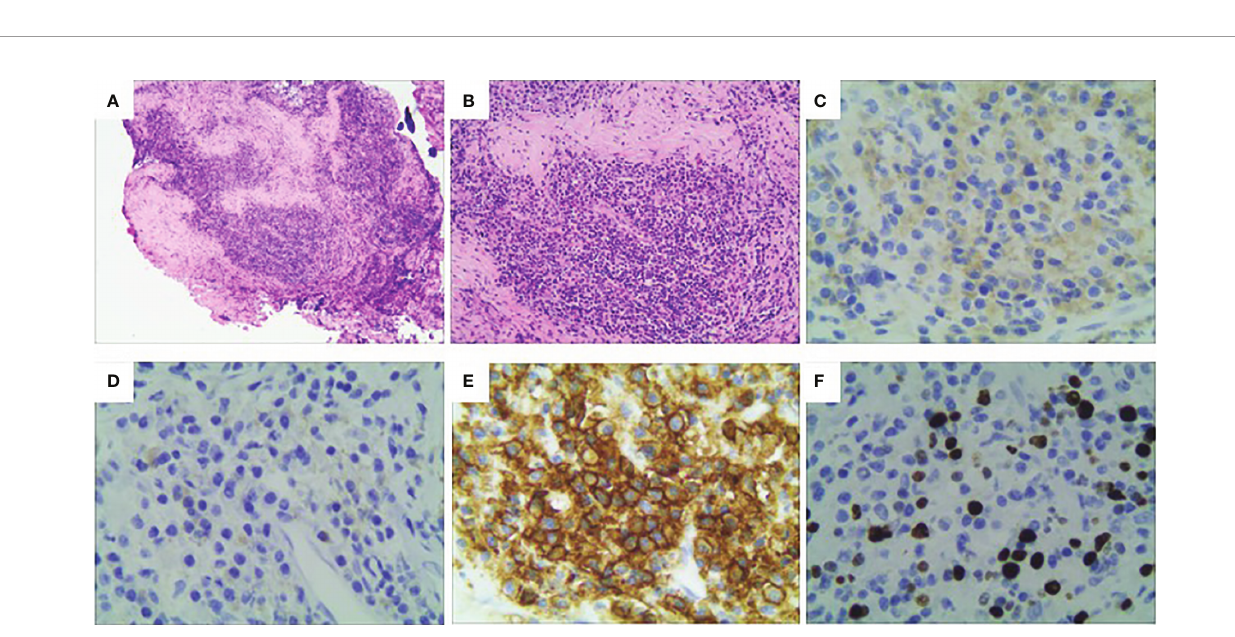
FIGURE 3 | Histological features of the lesion revealed an IgG4-related in fl ammatory pseudotumor. (A, B) Hematoxylin and eosin (H&E) stain showed the lesion was composed of sclerosing fi brosis associated with dense lymphoplasmacytic in fi ltration (A: ×40; B:×100); (C, D) Immunohistochemical analysis revealed over 400 IgG4-positive cells per high-powered fi eld and a high IgG4/IgG ratio (C, IgG, ×200; D, IgG4, ×200). (E) Immunohistochemical staining of CD38; (E) Immunohistochemical staining of Ki-67. (F) Immunohistochemical staining of